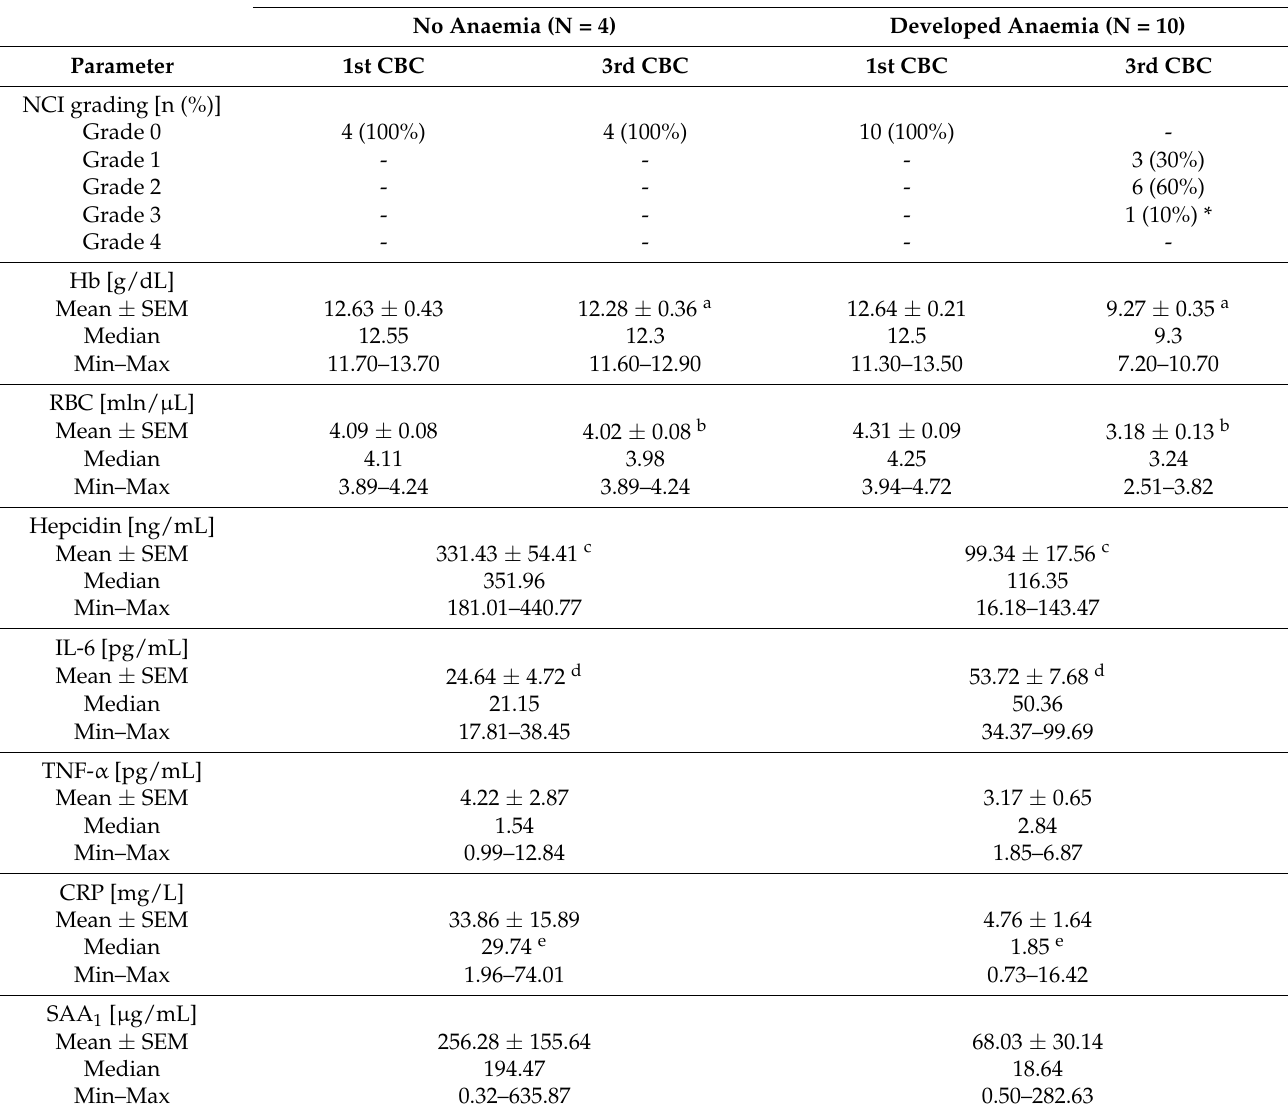
Table 4. Descriptive statistics of complete blood count parameters as well as hepcidin, IL-6, TNF- α , CRP, and SAA 1 levels in women with and without post-operative anaemia in the third complete blood count